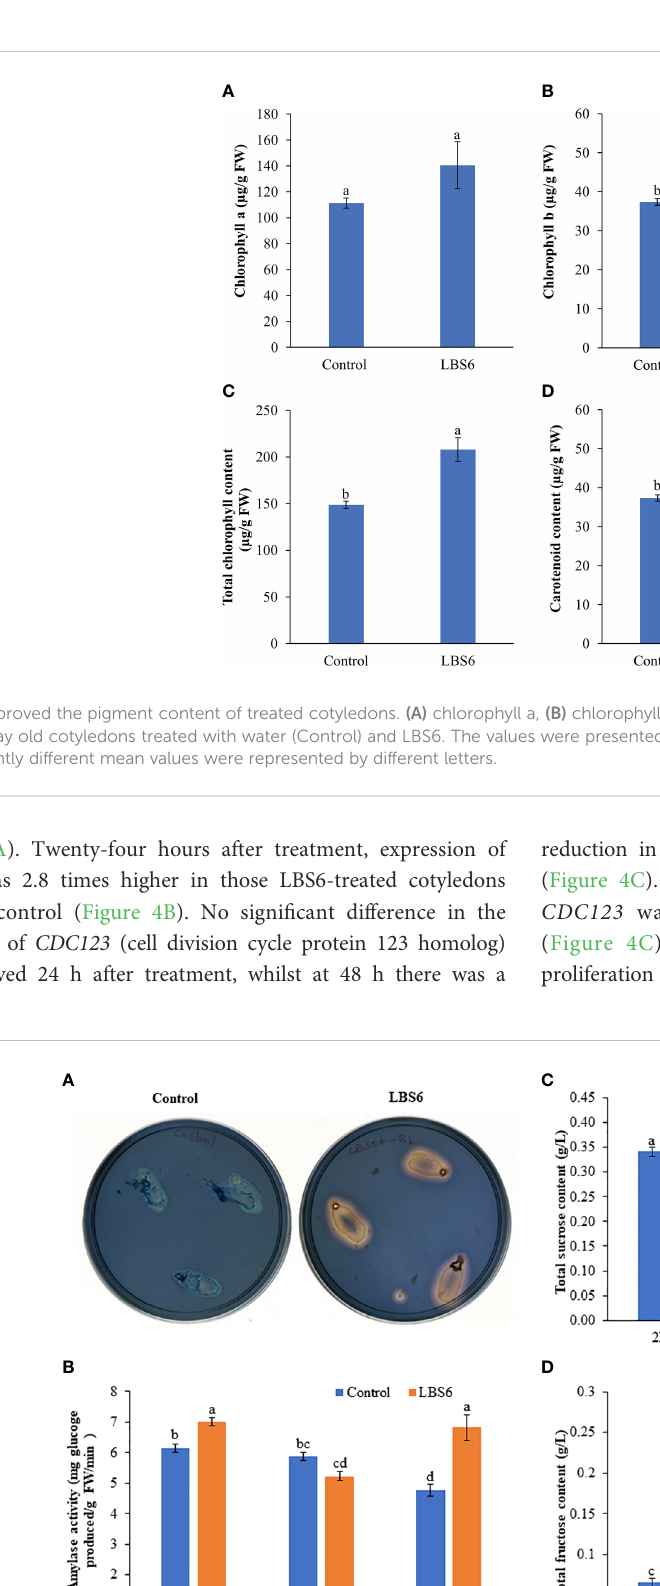
FIGURE 3 LBS6 modulated amylase activity and sucrose content. (A, B) Qualitative and quantitative amylase content in the cotyledon of cucumber. (C) Total sucrose, and (D) fructose content in the water (Control) and LBS6-treated cotyledons. The values were presented as mean ± SE of three independent replicates, and signi fi cantly different mean values were represented by different letters.